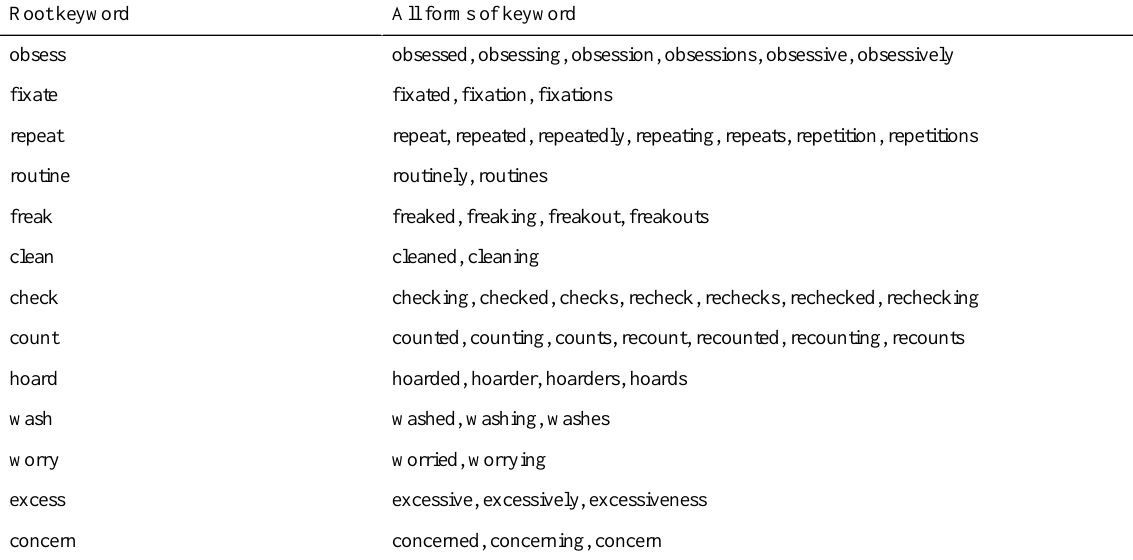
Table 2. All terms related to obsessive-compulsive disorder–related keywords.